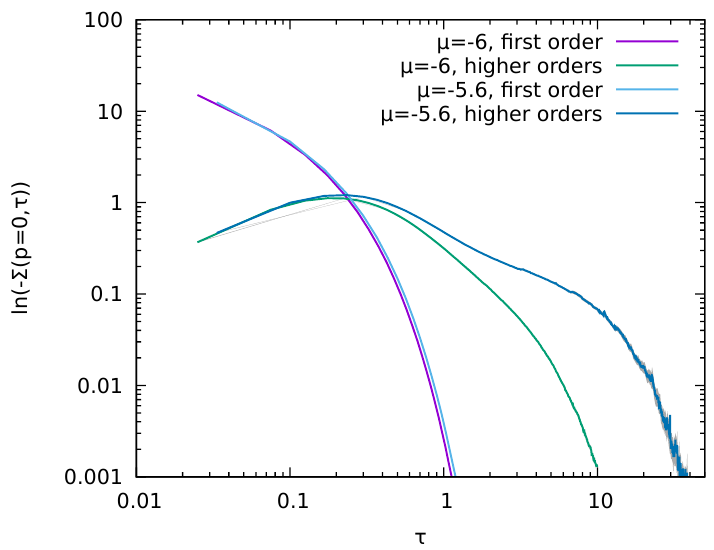
Figure 15: First order and higher orders of the self-energy Σ ( p = 0, τ ) for α = 5 and µ = − 6, − 5.6, respectively. Error bars are indicated by the region shaded in gray. Both simu- lations ran for 1330 CPU-hours